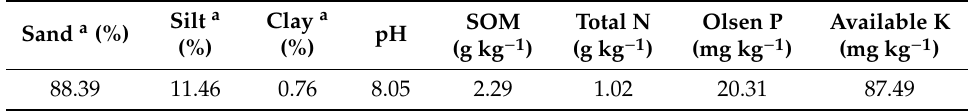
Table 1. Basic soil properties of the experimental site before the start of the experiment in 2013 winter wheat growing period in Cangzhou, Hebei, China North Plain.